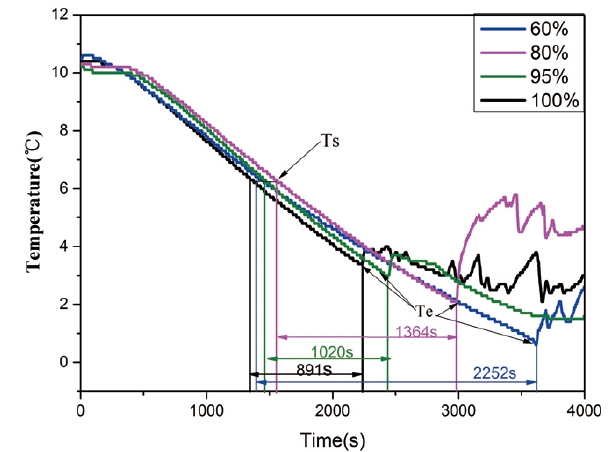
Figure 6. When the initial pressure, temperature, liquid holdup, and flow rate are constant, the hydrate induction time changes under different water cuts.